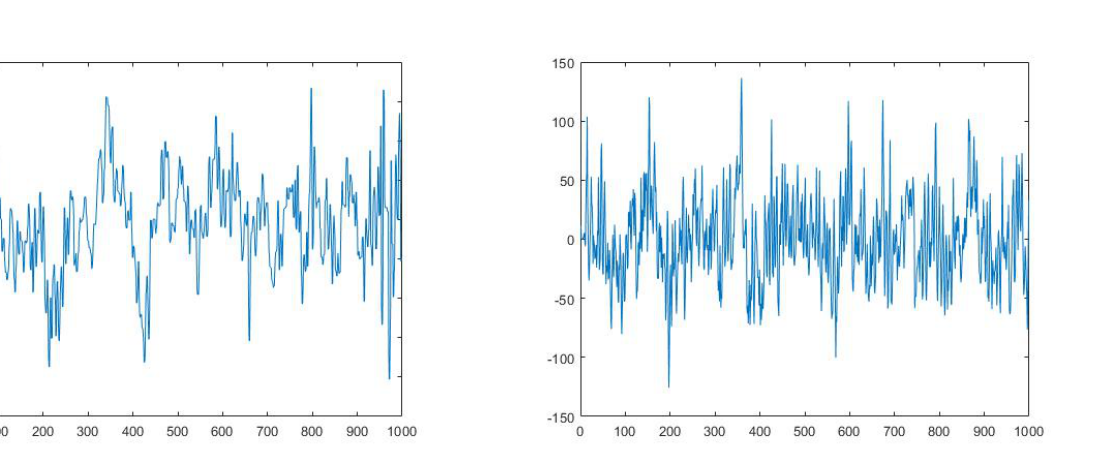
Figure 9. chb02-02 Median Filter Output